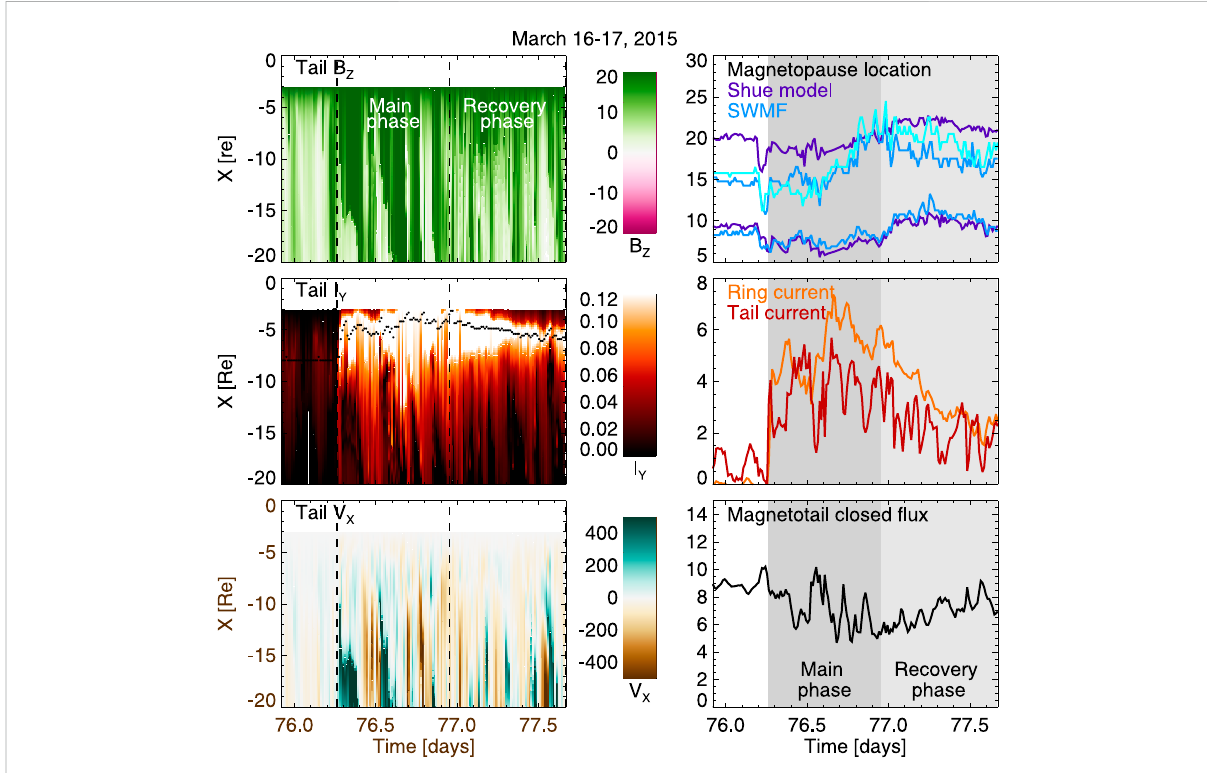
FIGURE 4 (Left panel) Simulation results along the magnetotail current sheet at the midnight meridian in a keogram format (see text for de fi nition of the current sheet surface): (Top) Tail B Z in nT; (Middle) Z -integrated current intensity (arbitrary units, seetext) with current peak intensity location shown with the black dotted line; (Bottom) Plasma velocity V X component in km/s. The storm main phase and recovery phases are de fi ned by the dotted lines. (Right panel) Characteristic numbers for the magnetospheric state: (Top) Magnetopause nose at Y = Z = 0 and magnetopause distance from the X -axis at Y = 0, X = − 10 R E . The Shue model is shown in dark blue, the SWMF Geospace values are shown in lighter blue. The southern lobe simulation value is shown with the lightest shade of blue; the Shue model is symmetric and gives the same value for northern and southern lobes. (Middle) Total ringcurrent (orange) andtail current(dark red)integratedalong thetaillength inMA (seetext); (Bottom)Closedmagnetic fl uxthrough the magnetotail at midnight meridian (arbitrary units, see text). Storm main phase (from onset to peak Dst) and recovery phase (from peak Dst to storm end) are shown with darker and lighter gray shading,